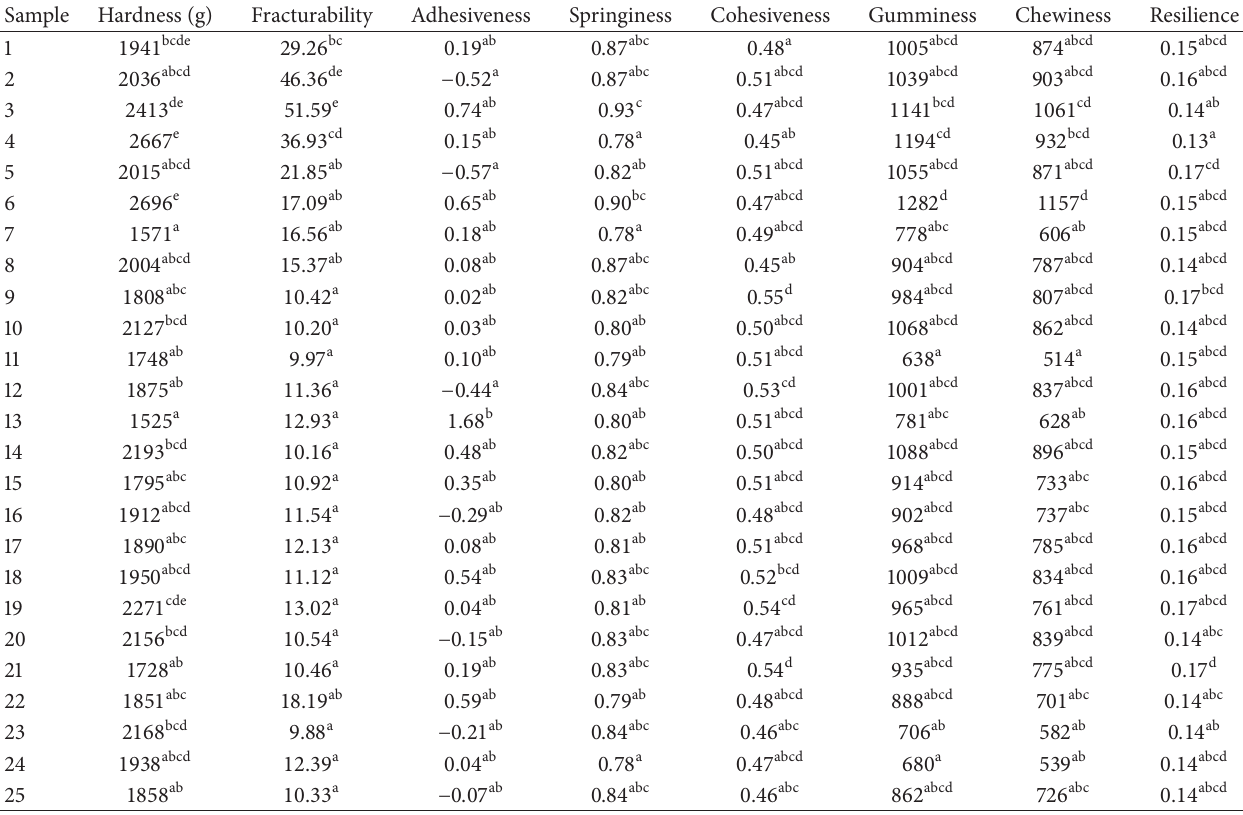
Table 4: Texture properties of all the fried fritters samples.